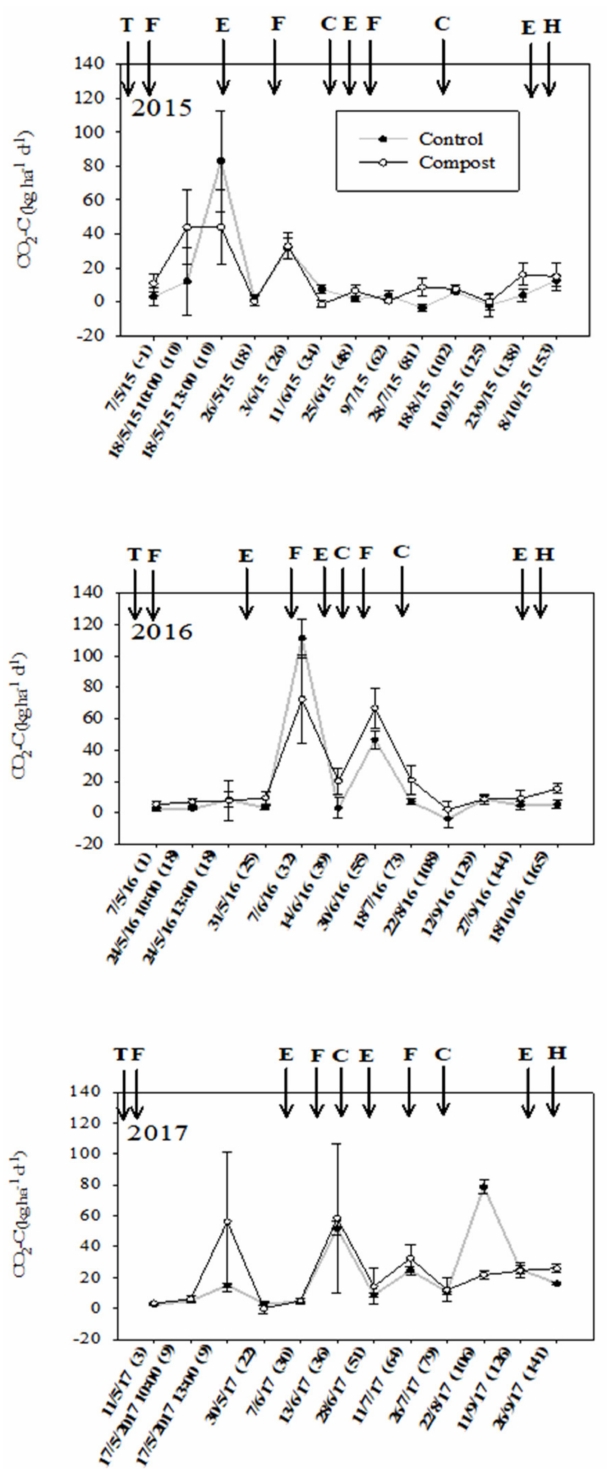
Figure 1. Effect of different management systems on CO 2 emission rates throughout rice growing cycle. The error bars represent the standard error of the mean ( n = 3). T: Tillage and fertilizer, C: Cover fertilizer, F: Flood, E: Emptying of terraces, H: Harvest. The numbers in parentheses on the x -axis indicate days after sowing